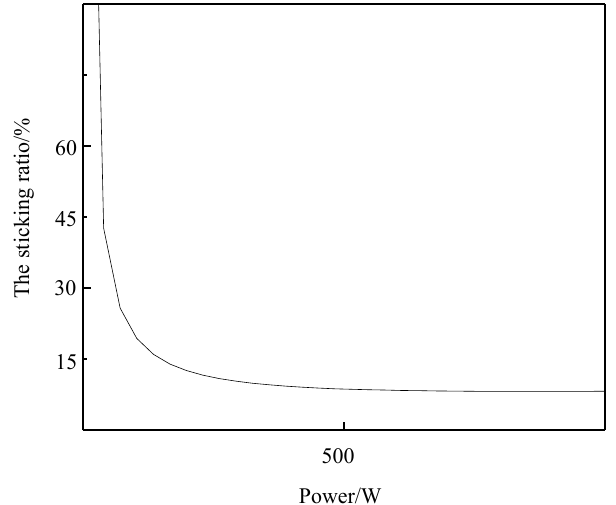
Figure 17. The functional relationship between the power and bond